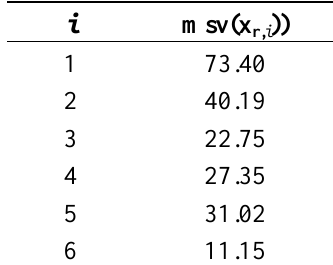
Table 2. The mean square values (msv) of the test deviation remaining content x covered with the reference principal components. For test observations 1–5, msv(x exceeds the acceptable value of msv = 11.53, indicating an improper motion in the associated swings